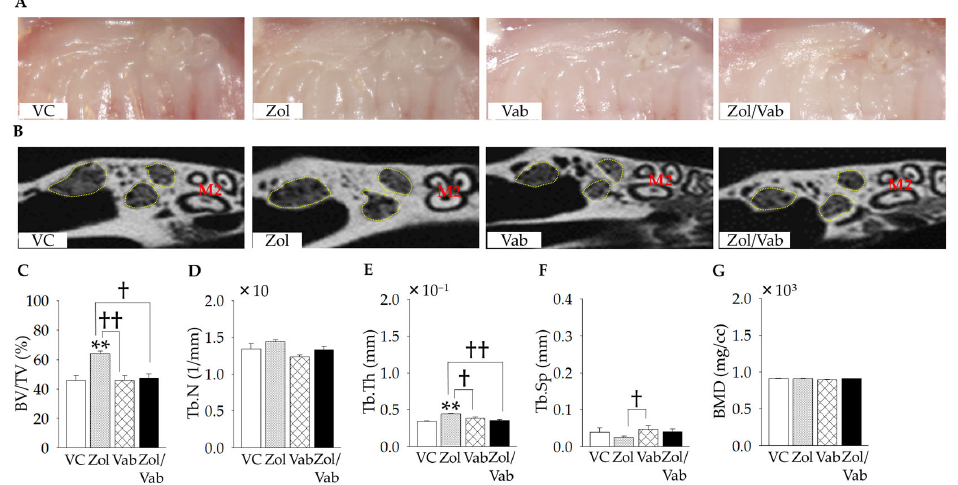
Figure 3. Effects of administered drugs on gross healing and bone architecture of tooth extraction sockets. ( A ) Representative intra ‐ oral photos in the occlusal view. No open wounds are noted in all groups. ( B ) Representative micro computed tomography images of tooth extraction sockets (yellow dotted surrounded areas: mesial and distal roots of first molars, M2: second molars). ( C ) Bone fill of tooth extraction sockets per tissue volume (BV/TV) is significantly higher in Zol vs. other comparison groups. ( D ) Trabecular number (Tb.N) is similar among the groups. ( E ) Trabecular thickness (Tb.Th) is significantly greater in Zol vs. other comparison groups. ( F ) Trabecular separation (Tb.Sp) is significantly smaller in Zol vs. Vab. ( G ) Bone mineral density (BMD) is similar in all groups. Graphs show means ± SEM. ** p < 0.01, † p < 0.05, †† p < 0.01; n = 5 mice/group.